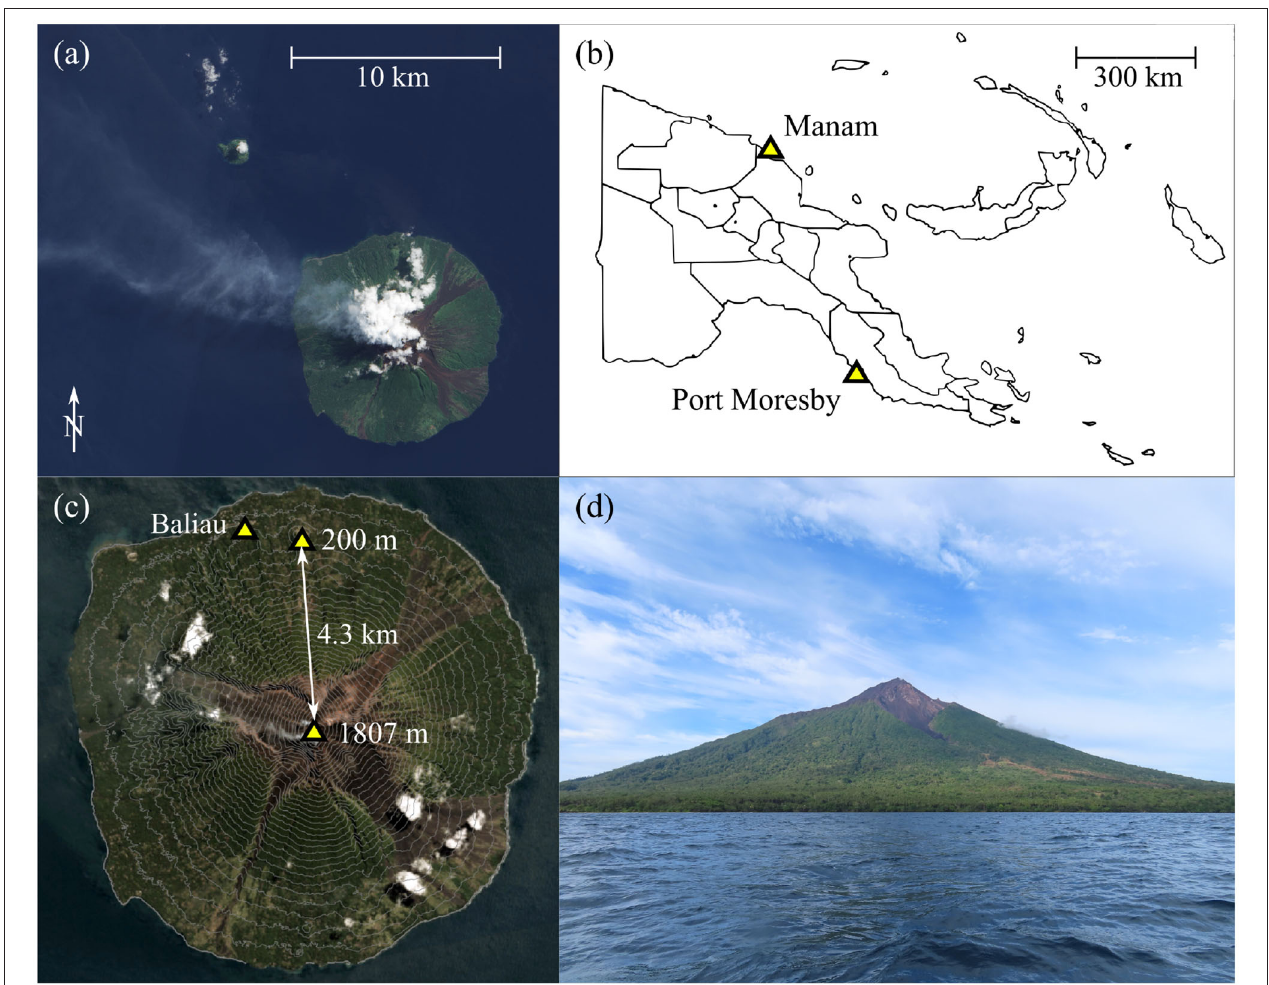
FIGURE 1 | (a) Satellite view of Manam with a visible plume drifting North-West. (b) Manam volcano is located on the Northern coast of mainland Papua new Guinea. (c) Each mission required flying to the summit from a small satellite cone located 4.3km from the summit crater, near the village of Baliau. Note the satellite image has been overlayed with contour lines indicating the steep terrain. (d) A clear view of Manam volcano from the approach by